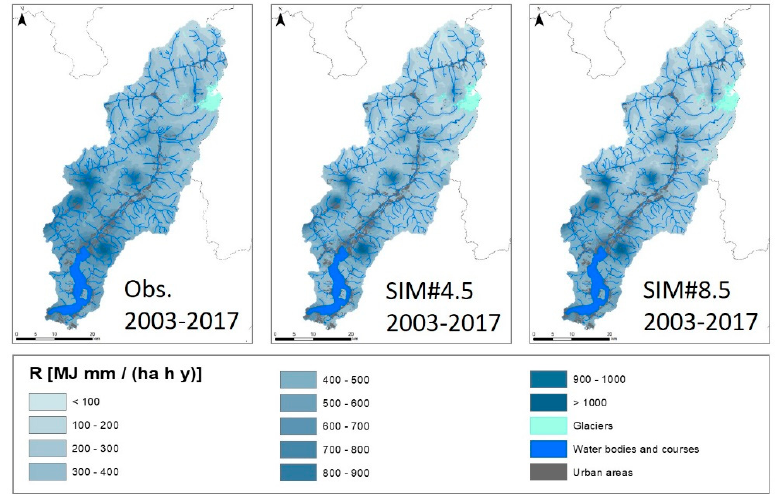
Figure 7. Estimates of R-factor based on observations in 2003–2017 (left); statistical downscaling of SIM#4.5 in 2003–2017 (center); statistical downscaling of SIM#8.5 in 2003–2017 (right).